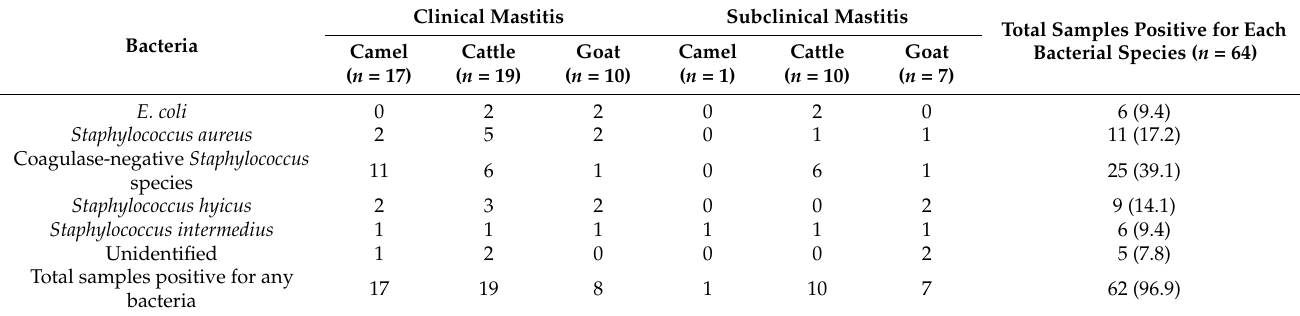
Table 7. Bacterial species isolated from milk samples and their frequency of detection by animal species and by clini- cal/subclinical